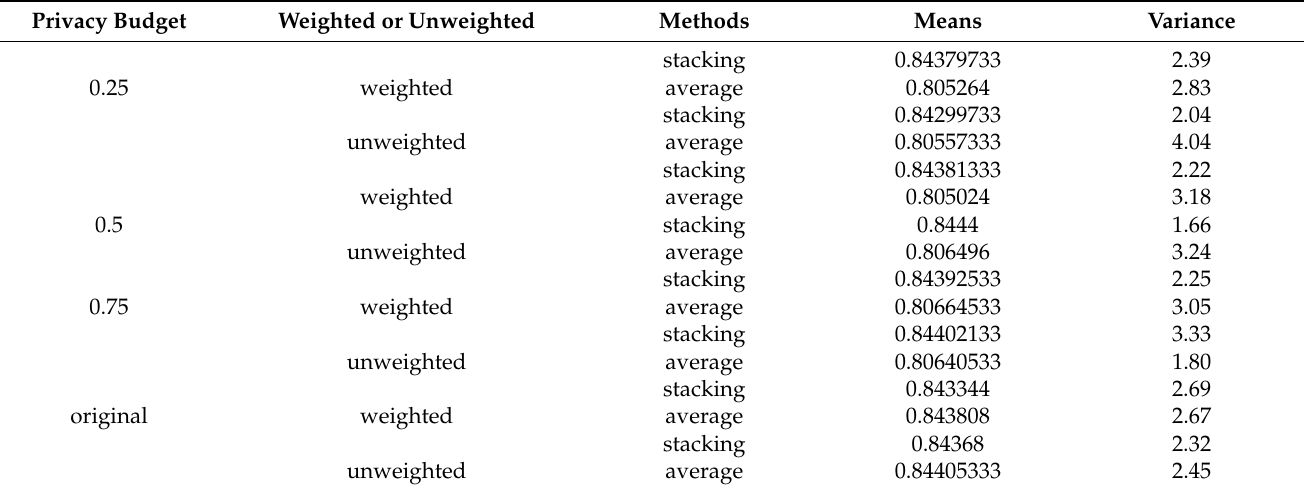
Table 2. A table of changes in the situation of the updated global model h 1 over t 1 time using different methods.